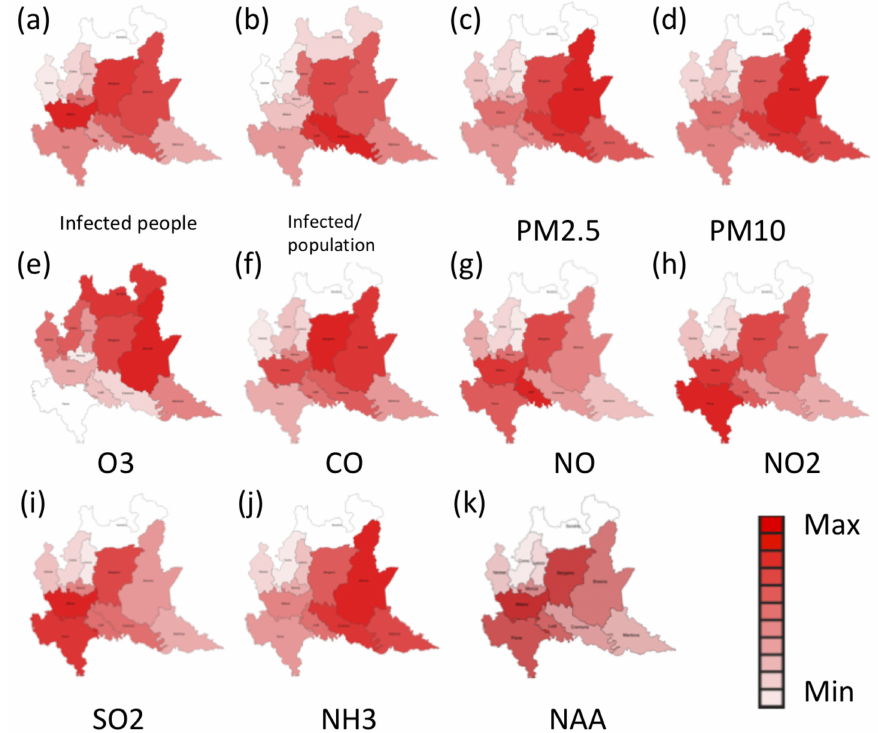
Figure 1. Distribution over the different provinces of Lombardy of ( a ) total number of infected people, ( b ) daily prevalence rate (Infected /population), ( c ) average concentration of particulate matter 2.5 (PM 2.5), ( d ) average concentration of particulate matter 10 (PM10), ( e ) ozone (O 3 ), ( f ) carbon monoxide (CO), ( g ) nitric oxide (NO), ( h ) nitrogen dioxide (NO 2 ), ( i ) sulfur dioxide (SO 2 ), ( j ) ammonia (NH 3 ) and ( k ) net atmospheric acidity (NAA) during the considered time